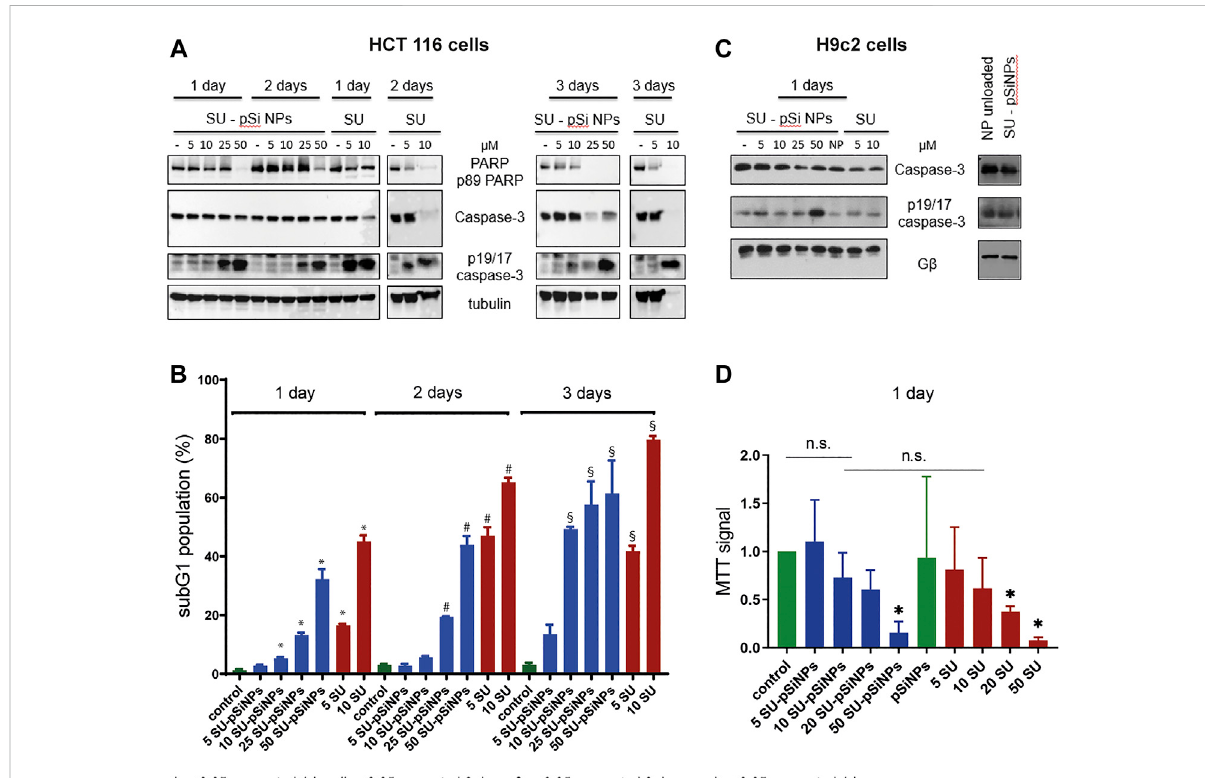
FIGURE 6 (A – D) HCT 116 cells and H9c2 cells were treated with sunitinib-loaded nanoparticles (SU-pSiNP) or pure sunitinib (SU) or unloaded nanoparticles (NP unloaded, (C) , right panel) in the indicated concentrations ( μ M) and for the indicated time intervals. In (A) and (C), the representative WB of expression levels of apoptotic marker proteins PARP, caspase-3, and cleaved caspase (p19/17 fragments of caspase-3, p19/ 17 caspase-3) are shown. G β and tubulin were used as loading controls. Blots were reproduced at least three times with similar results. (B) The histogram of fl owcytometricanalysisdatafor HCT116cells usingsubG1assay; %:percent ofSubG1 population.Results areshown asmean values ± standard deviation (SD), n = 3, * p < 0.05 vs. control 1 day, # p < 0.05 vs. control 2 days, § p < 0.05 vs. control 3 days, n.s. not signi fi cant. (D) MTT cell viability assay of H9c2 cells upon treatment with SU-pSiNPs and pure SU in indicated concentrations ( μ M) for 1 day. Results are presented as mean values ± standard deviation (SD), n = 3, * p < 0.05 vs. untreated control and pSiNPs-treated group. Ordinary one-way ANOVA was applied